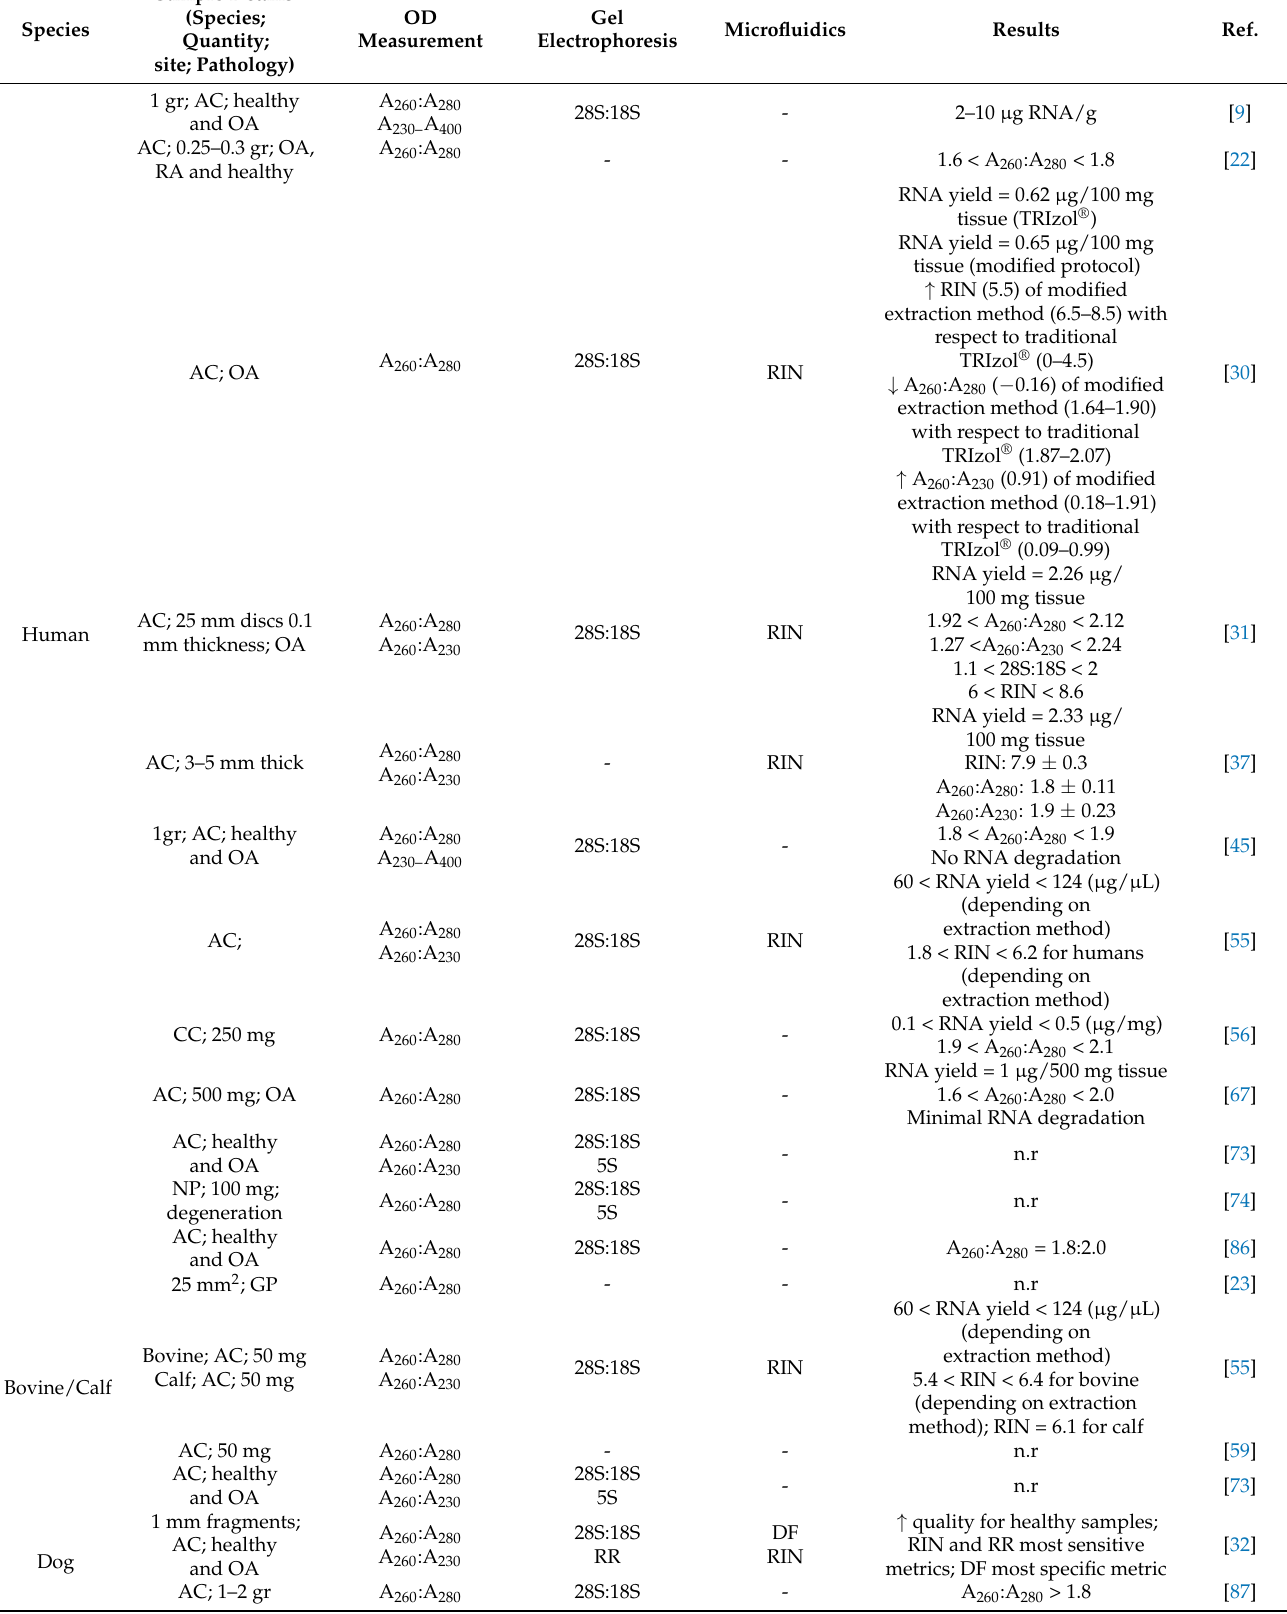
Table 5. Quality and integrity parameters evaluated by authors and the corresponding